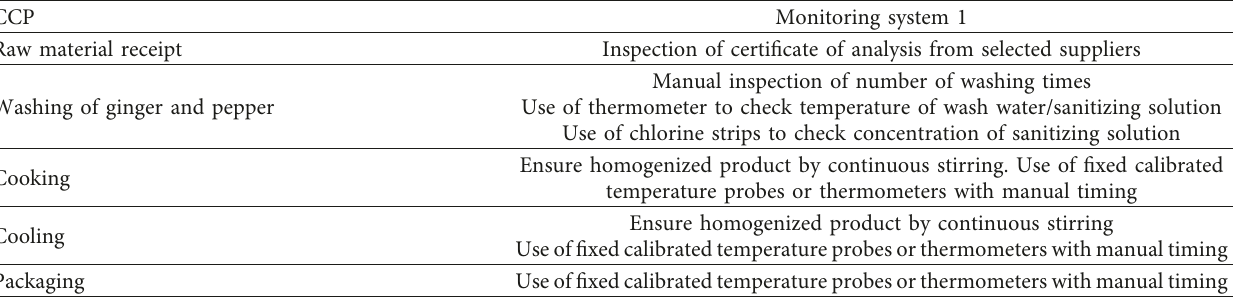
Table 3: Alternative monitoring systems for the